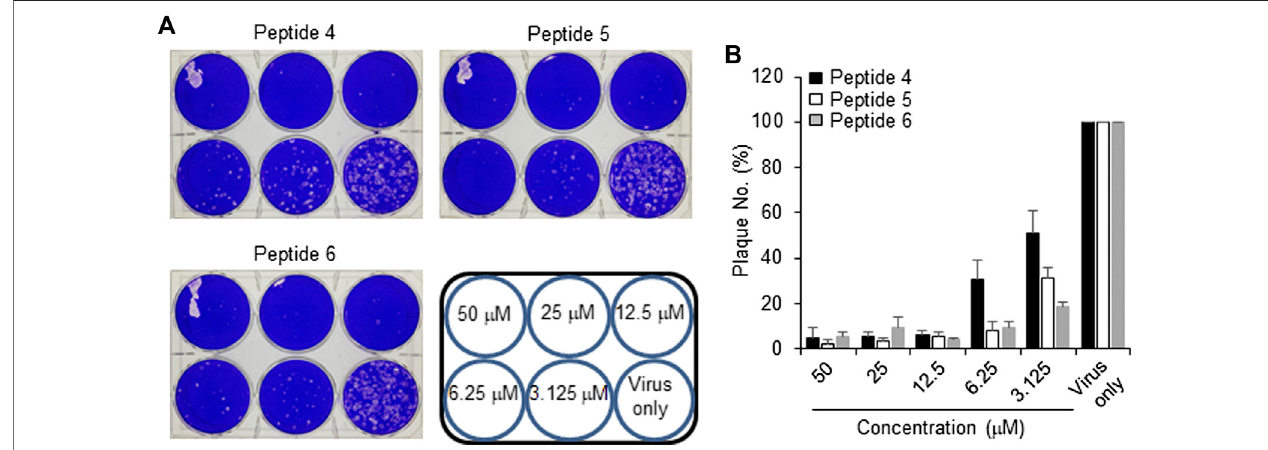
FIGURE 5 | Effect of inhibitor peptides on MERS-CoV infection. MERS-CoV was pre-incubated with two-fold serially diluted peptide 4, 5 or 6 ( n (cid:1) 3) for 30 min at 37 ° C. Vero cells were treated with the mixture of the virus and each peptide and then incubated for 4 days in DMEM/F12 containing0.6% oxoid agar. The plaques were observed by staining with crystal violet and counted (A) A representative picture showing the plaque reduction assay (B) Quanti fi cation of the plaque reduction assay against MERS-CoV after treatment with each peptide.